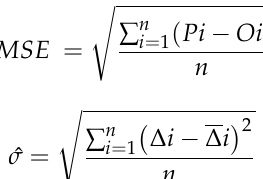
Figure 12. Movement of the height of the DMV of the Petrovaradin Fortress area.